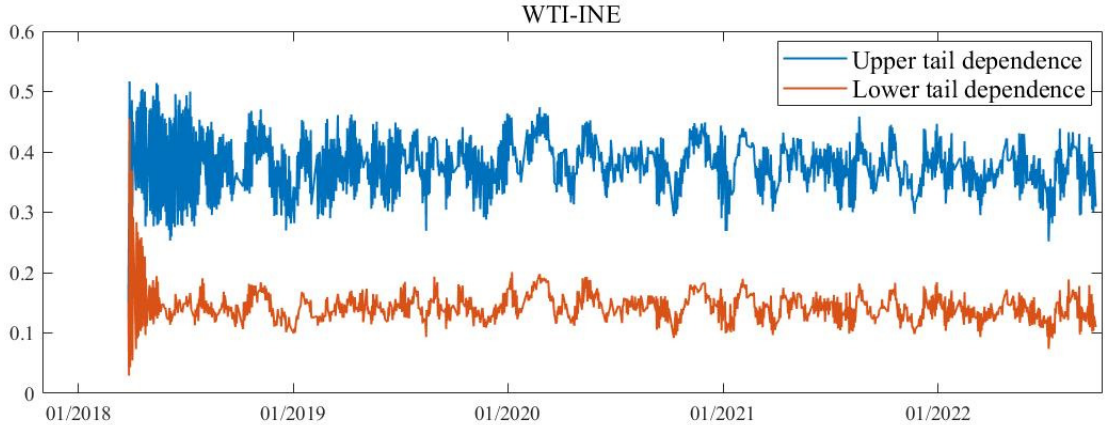
Figure 4. Time-varying tail dependences between INE crude oil futures and WTI crude oil futures.